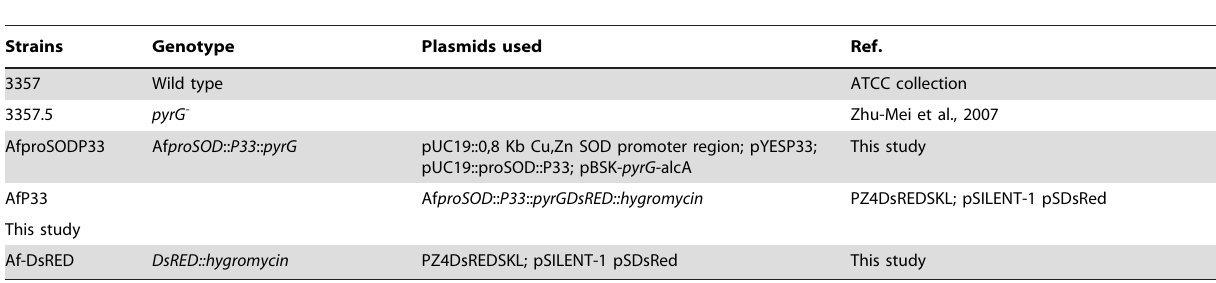
Analysis of 9- and 13- HPODE in mycelia The WT and AfP33 collected from CDB cultures at different incubation times were homogenized in liquid nitrogen to avoid the Table 2 . A. flavus strains used in this